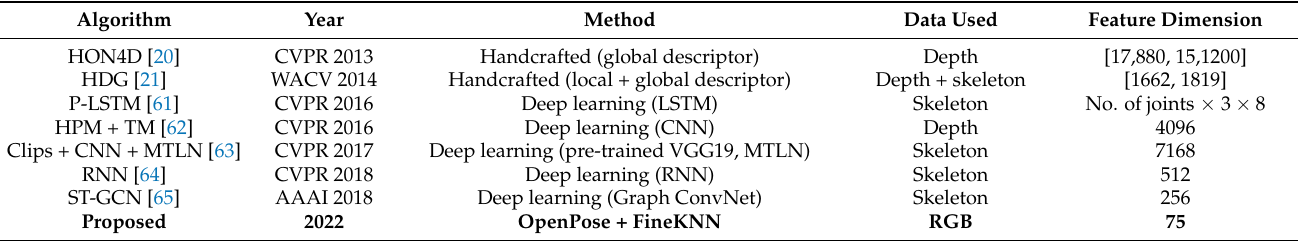
Table 10. Comparison of feature